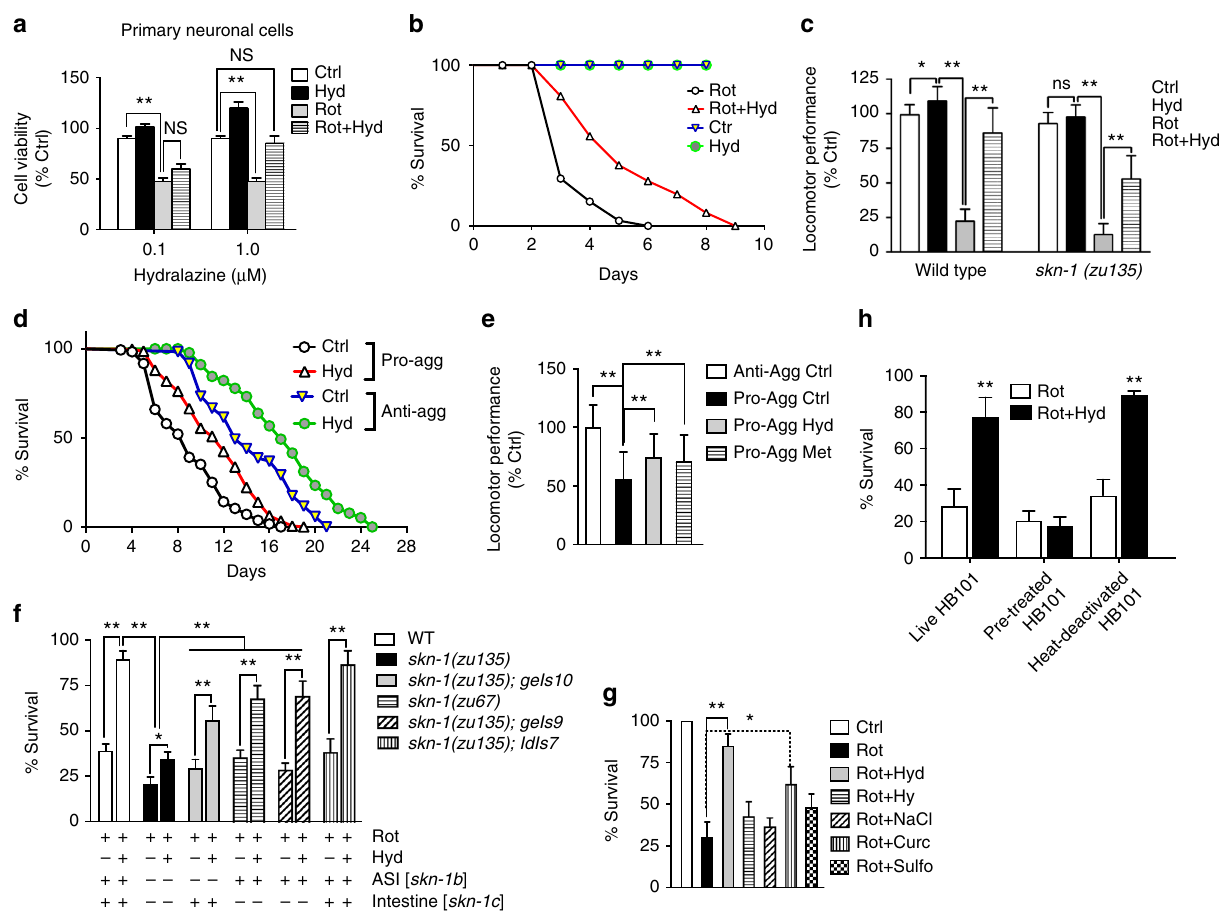
Fig. 6 Hydralazine protects neuronal cells and C. elegans from various stressors. a Hydralazine signi fi cantly protected primary neuronal cells from rotenone (1 µ M) induced death. ** p < 0.01, two-tailed Student's t test, n = 6, mean ± SD. b Hydralazine (100 µ M) signi fi cantly protected C. elegans against rotenone- induced mortality. p < 0.0001, Log-rank (Mantel-Cox) test, n = 101. c Hydralazine pretreatment (100 µ M) prevented rotenone-induced reduction in locomotion of wild-type worms. skn-1 ( zu135) mutants were more vulnerable to rotenone toxicity but still experienced signi fi cant protection against rotenone with hydralazine treatment. * p < 0.05 and ** p < 0.01, two-tailed Student's t test, n = 70 three independent trials, mean ± SD. d Hydralazine (100 µ M) protected control and tauopathy model C. elegans expressing anti-aggregate tau ( byIs194 ) or pro-aggregate tau ( byIs161 ) in the nervous system. For statistics see Supplementary Table 2 online. e The de fi cit in locomotor performance of tauopathy model C. elegans at day 5 was restored with 100 µ M hydralazine treatment. 20 mM metformin was used as positive control. ** p < 0.001, two-tailed Student's t test, n = 45 three independent trials, mean ± SD. f Hydralazine protection (100 µ M) was attenuated in zu135 skn-1 mutant. Presence of a functional copy of SKN-1 isoform C in geIs10 transgenic animals or SKN-1 isoform B in skn-1(zu67) or geIs9 transgenic animals partially restored hydralazine-mediated protection against rotenone-induced mortality. Integration of SKN-1 isoforms B and C ( ldIs7 ) resulted in maximum protection against rotenone-induced death. * p < 0.05 and ** p < 0.01, two-tailed Student's t test, n = 240 three independent trials, mean ± SD. g Worms pretreated with 100 µ M of hydralazine or curcumin for 3 days were protected from rotenone-induced toxicity. Worms pretreated with the same concentration of hydrazine, NaCl, or sulforaphane were not. * p < 0.05 and ** p < 0.01, two- tailed Student's t test, n = 210 two independent trials, mean ± SD. h Hydralazine treatment (100 µ M) protected C. elegans against rotenone cytotoxicity when animals were fed either live or heat-inactivated bacteria but not when they were fed hydralazine pretreated bacteria, indicating a